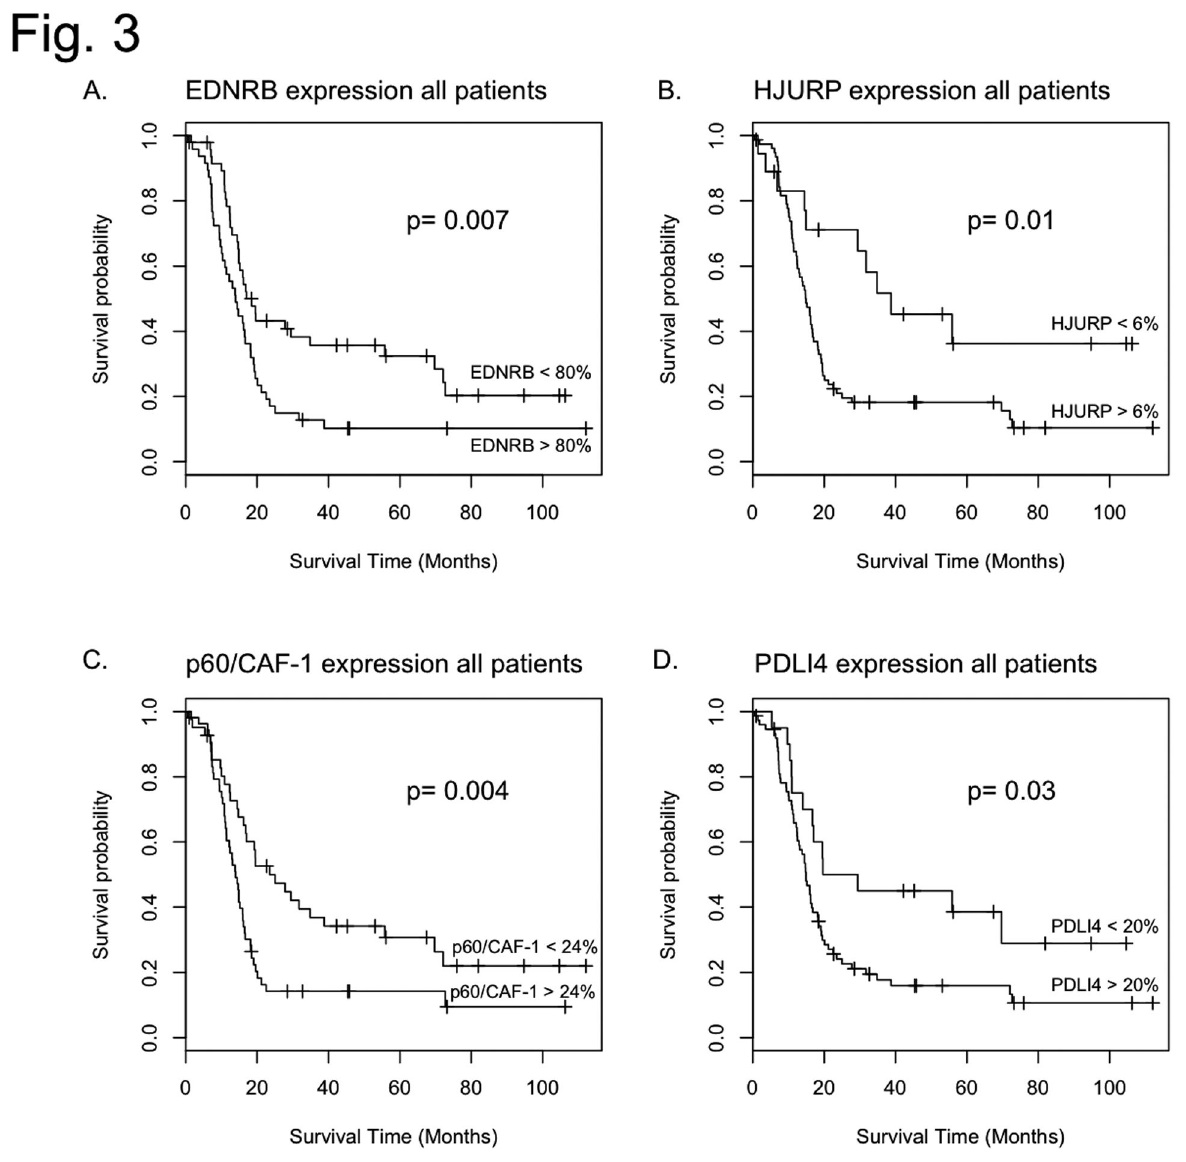
Figure 3. Overall survival analyses of molecular markers. Kaplan–Meier estimates of overall survival are presented for all markers (EDN/RB, HJURP, p60/CAF-1 and PDLI4), after subdivision of the cohort of patients into two groups (low and high risk of death) on the basis of the cut-off points defined by analyses of time-dependent ROC curves. Panel A. For the EDN/RB protein, median overall survival for low-risk patients was 18.5 months (95% CI, 14.9-69.7), whereas that for high-risk patients was 14 months (95% CI, 10.4-18.3) (P=0.007). Panel B. For the HJURP protein, the difference in overall survival between low-risk and high- risk patients is significant (P=0.01 with 38.8 months [95% CI, 29.4-12.5] versus 14.9 months [95% CI, 12.5 to 17], respectively). Panel C. For the p60/CAF-1 protein, the difference in overall survival between high-risk and low-risk patients was also significant (p=0.004, 14 months [95% CI, 11.4-16.2] versus 23.5 months [95% CI, 16.8-55.8], respectively). Panel D. For the PDLI4 protein, the difference is also significant (P=0.02, 14.9 months [95% CI, 13-18.2] versus 19.6 months [95% CI, 16.7-Inf]).